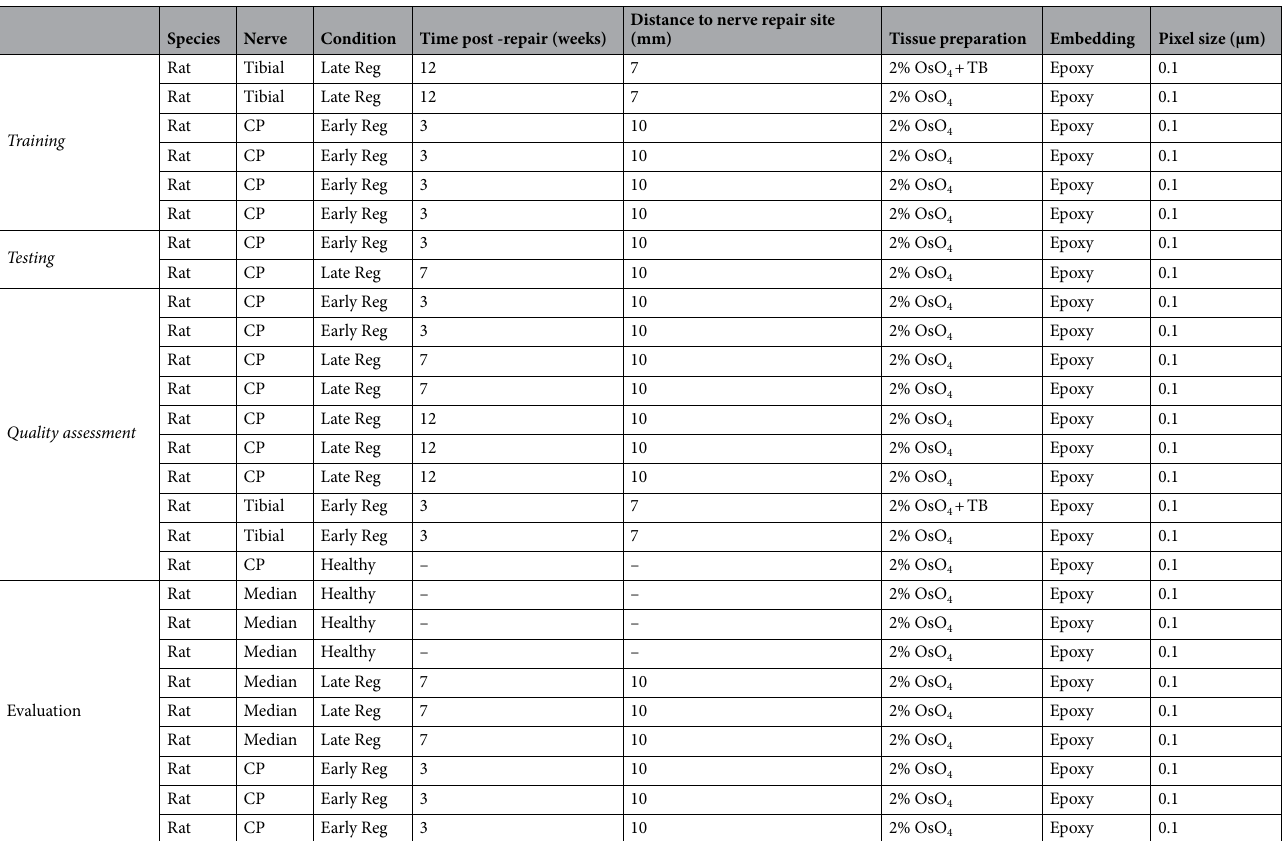
Table 1. Datasets for training and evaluation. Training was performed on 6 light-microscopic cross-sectional images of osmium tetroxide stained, epoxy embedded rat nerves at various nerve regeneration stages. Another 12 images were used for testing and quality assessments. Performance of the trained model was evaluated using a separate image set including a total of 9 light-microscopic cross-sectional images of osmium tetroxide- stained epoxy embedded healthy and regenerating rat nerves. CP common peroneal nerve, Tibial tibial nerve, Median median nerve, Early Reg . early nerve regeneration stage, Late Reg . late nerve regeneration stage, OsO 4 osmium tetroxide, TB toluidine blue